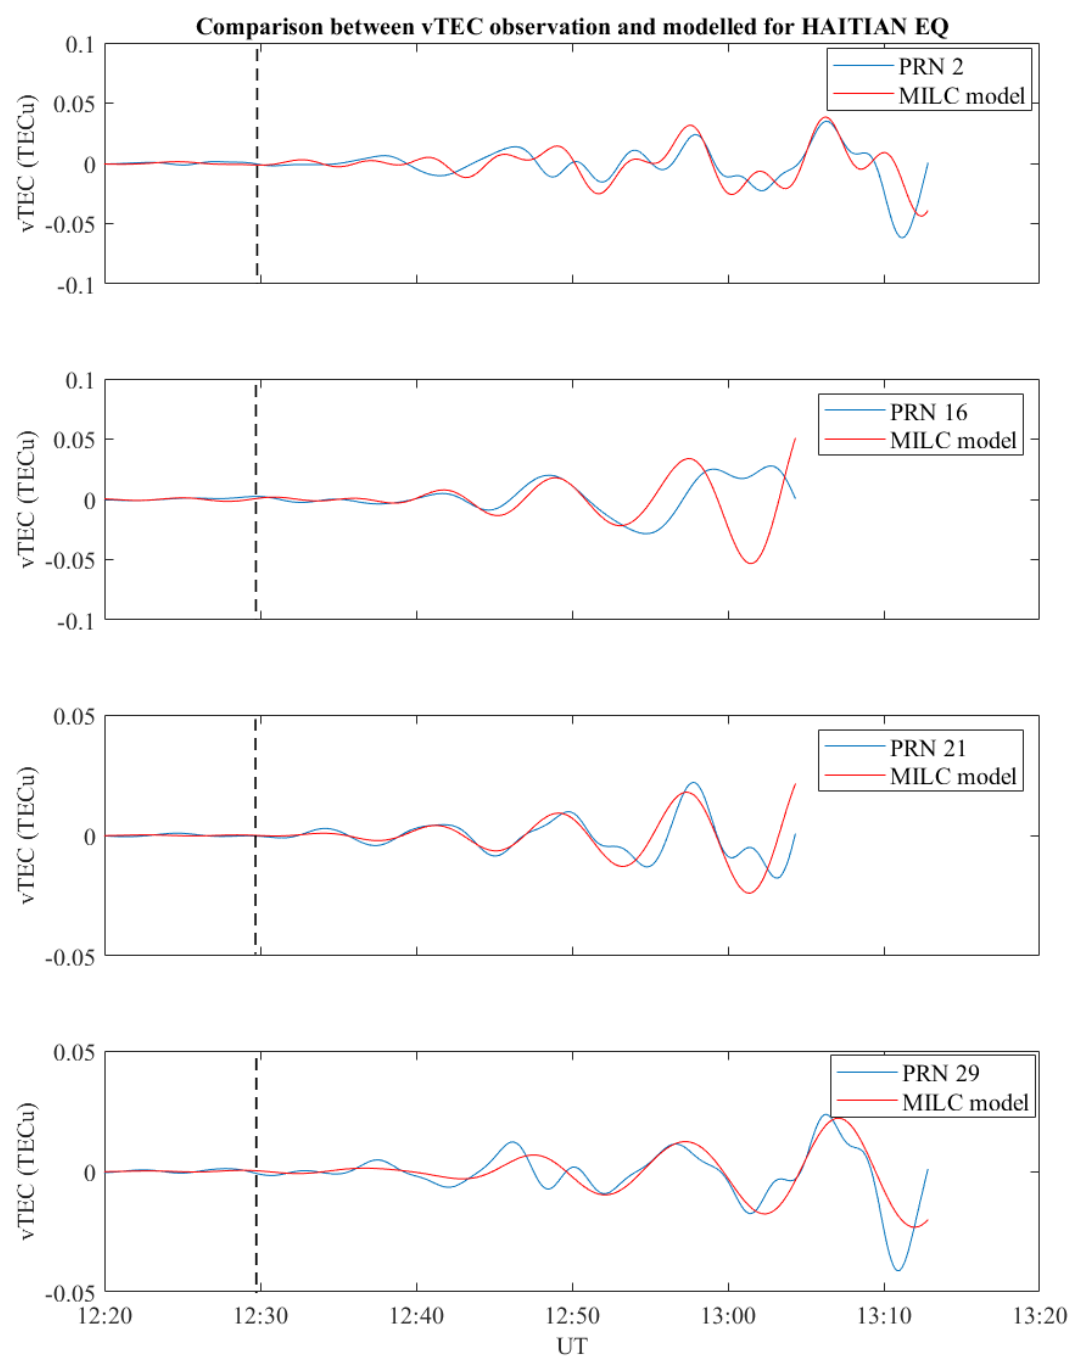
Figure 9. Comparison between the vTEC fluctuations as observed (blue line) and predicted (red line) by the MILC model for four different GNSS satellites. The black vertical dashed line represents the time of the EQ occurrence.